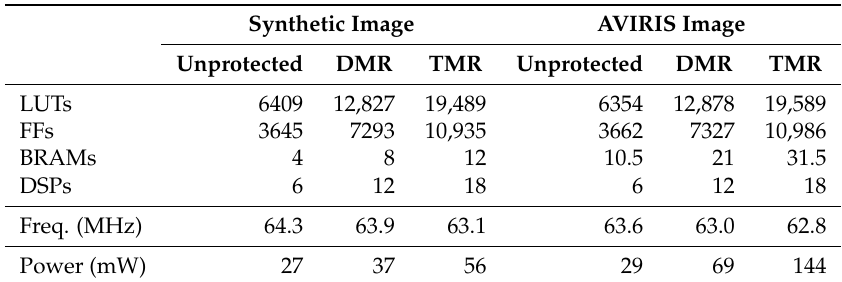
Table 5. Area overhead and power consumption of the different unprotected and protected architectures.